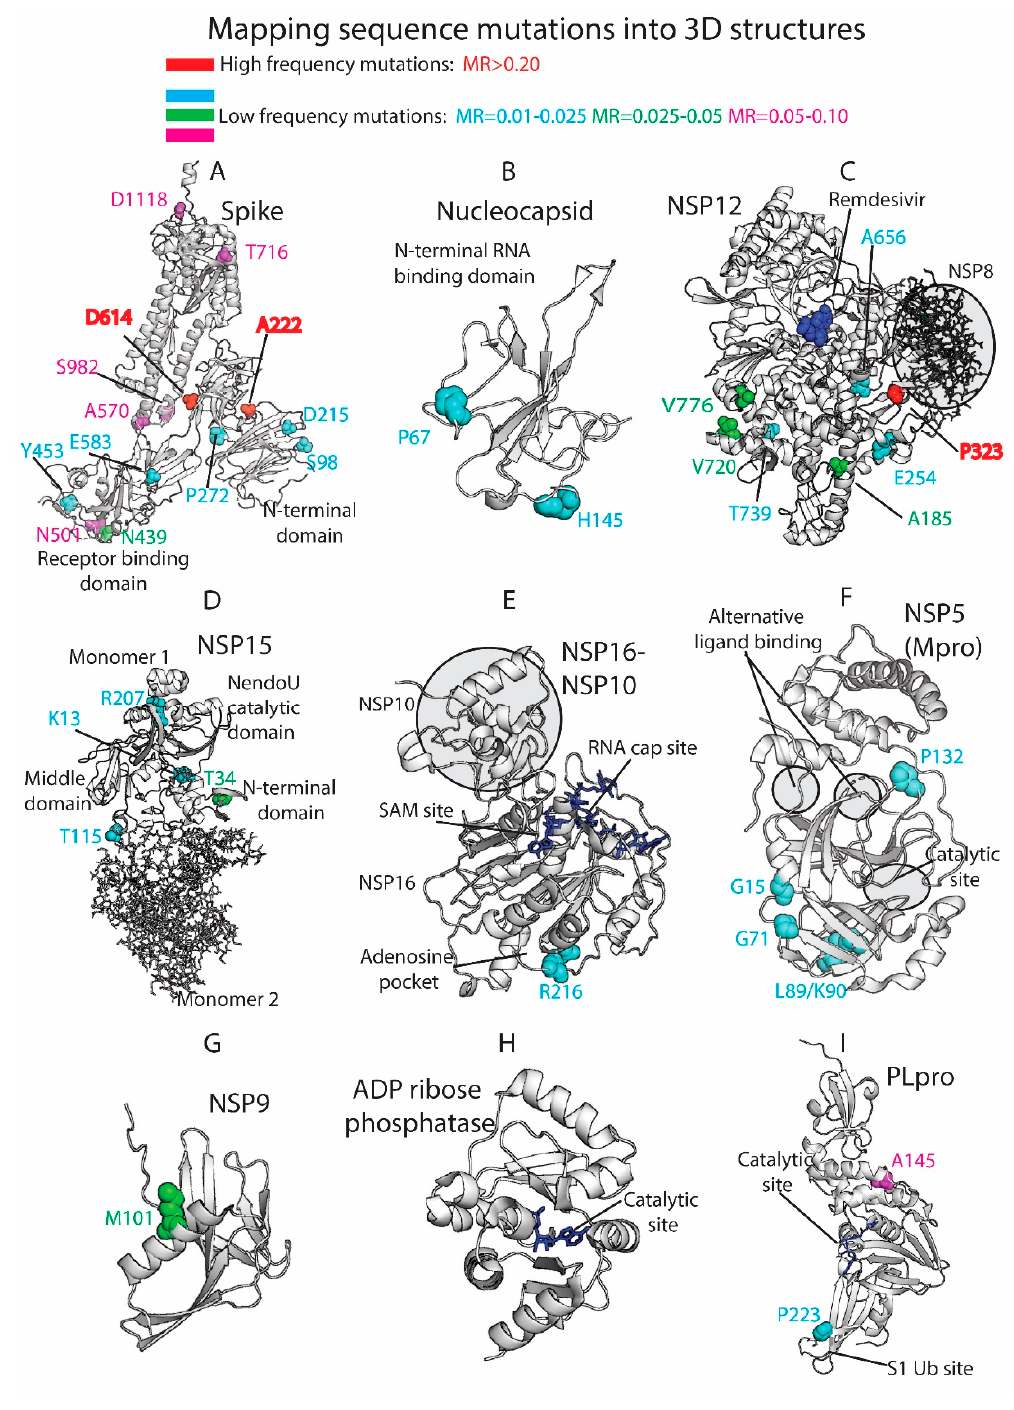
Figure 4. Three-dimensional (3D) protein structures colored by residue mutation rates: Spike, Nucleocapsid, RdRp (NSP12), Endoribonuclease (NSP15), NSP16-NSP10 heterodimer, Mpro (NSP5), NSP9, ADP ribose phosphatase (NSP3), and Papain-like protease (PLpro, NSP3). Proteins represented in white ribbons (MRs < 0.01) and color-coded residues (cyan: MRs = 0.01–0.025, green: MRs = 0.025–0.05, magenta: MRs = 0.05–0.10, red: MRs > 0.20. No residues with MR values between 0.10 and 0.20 were available in the shown crystallized structures).